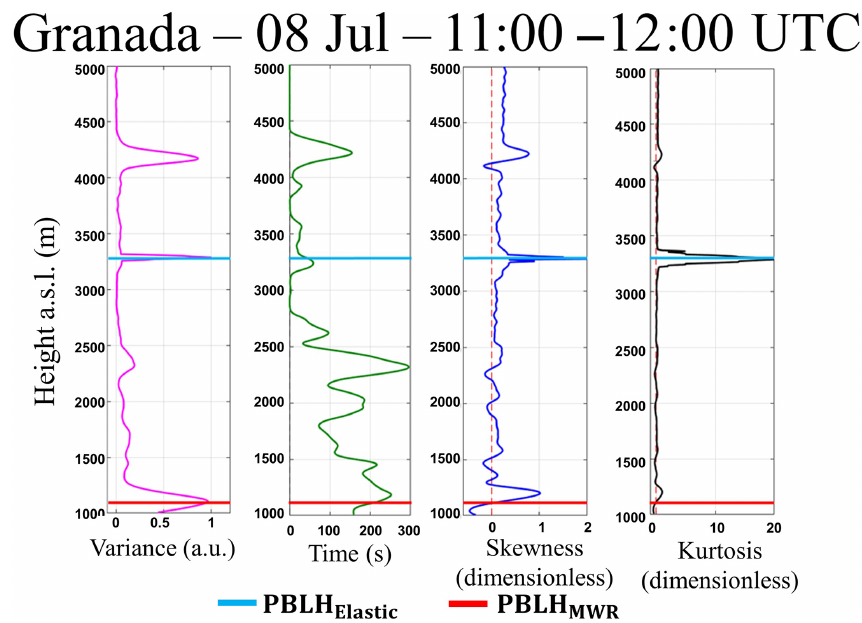
Figure 17. Statistical moments obtained from 1064nm wavelength data of elastic lidar (MULHACÉN) in Granada from 11:00–12:00UTC on 8 July 2016. From left to right is the variance ( σ 2 ), integral timescale ( τ RCS (cid:48) ), skewness ( S RCS (cid:48) ) and kurtosis ( K RCS (cid:48) RCS (cid:48)